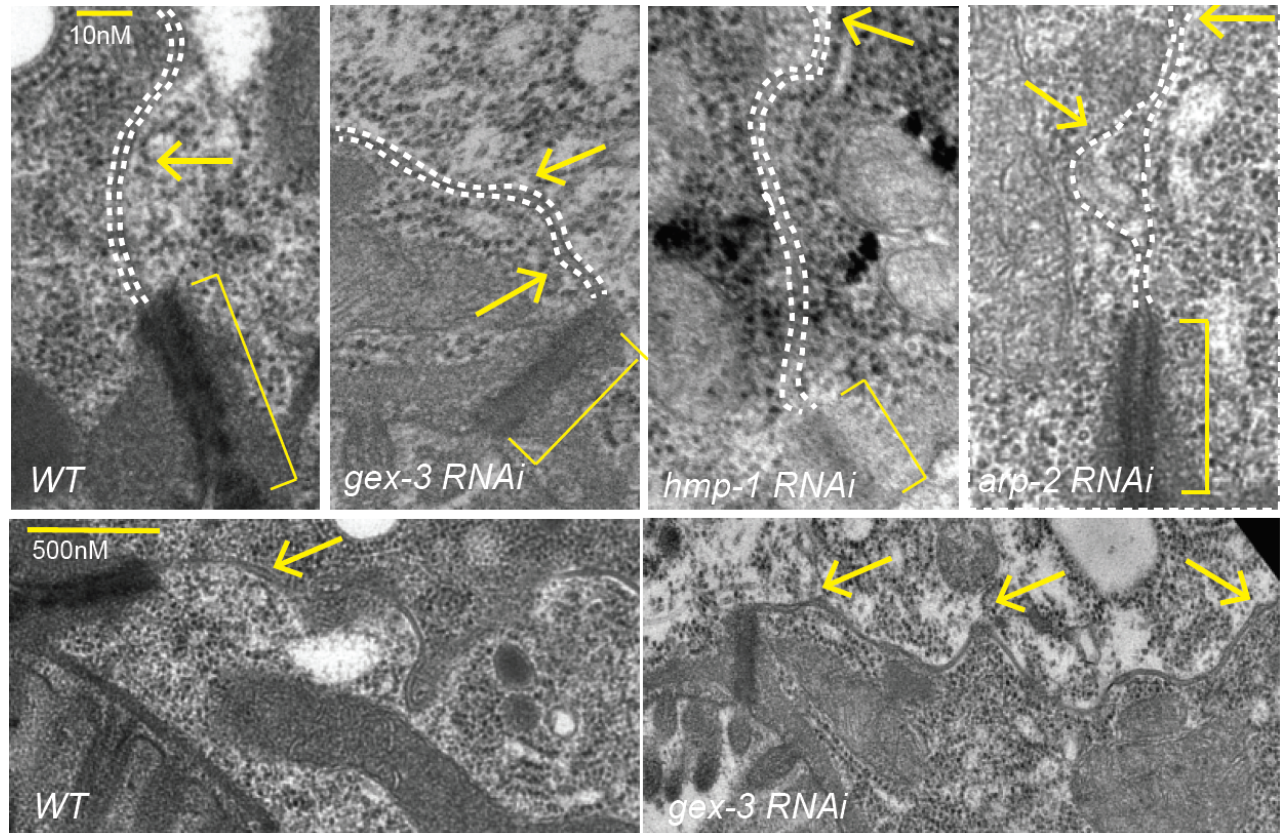
Figure 4. Electron micrographs (EM) analysis of adult intestines show effect of reducing gex-3 or arp-2 on lateral membranes. Electron micrographs to compare apical and lateral regions of the adult intestine in control animals and animals depleted of components of the WAVE complex ( gex-3 ), Cadherin complex ( hmp-1 ) or Arp2/3 complex ( arp-2 ) via RNAi feeding. Brackets indicate the electron-dense apical junction. Arrows point to the lateral membrane between two intestinal cells, including regions of membrane separation. Dotted white lines follow the lateral membranes between two intestinal cells. * = p < 0.05, ** = p < 0.005, *** = p < 0.0005, ns = not significant.